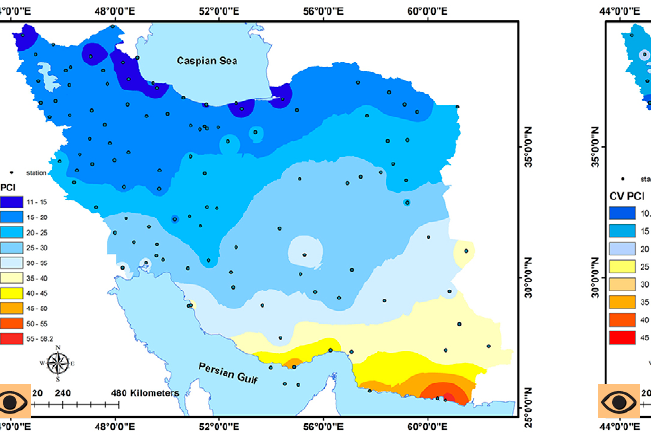
Figure 5. The coefficients of variation (CV) of PCI across Iran over the period